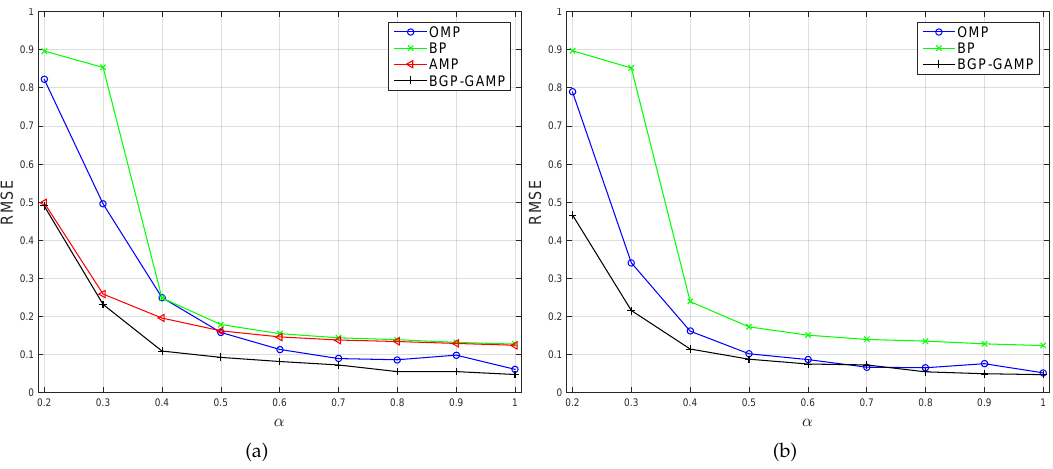
Figure 2. Reconstruction performance comparison of the highly column correlations sensing matrix. ( a ) Type-1 sensing matrix; ( b ) Type-2 sensing